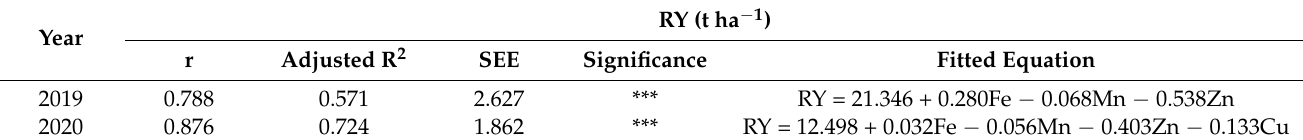
Stepwise regression analysis in Table 7 and Figures 15–21 indicates that 57.1% of variations in TY of sweet potato are explained by variations in four leaf nutrients (i.e., Fe, Mn, and Zn) in the 2019 season, and 72.4% by variations in four leaf nutrients (i.e., Fe, Mn, Zn, and Cu) in the 2020 season. Table 7. Proportional contribution in predicting total tuberous root yield (RY) using stepwise multiple linear regression for stressed sweet potato plants sprayed with different levels of ascorbic acid and zinc oxide nanoparticles in both the 2019 and 2020 seasons.